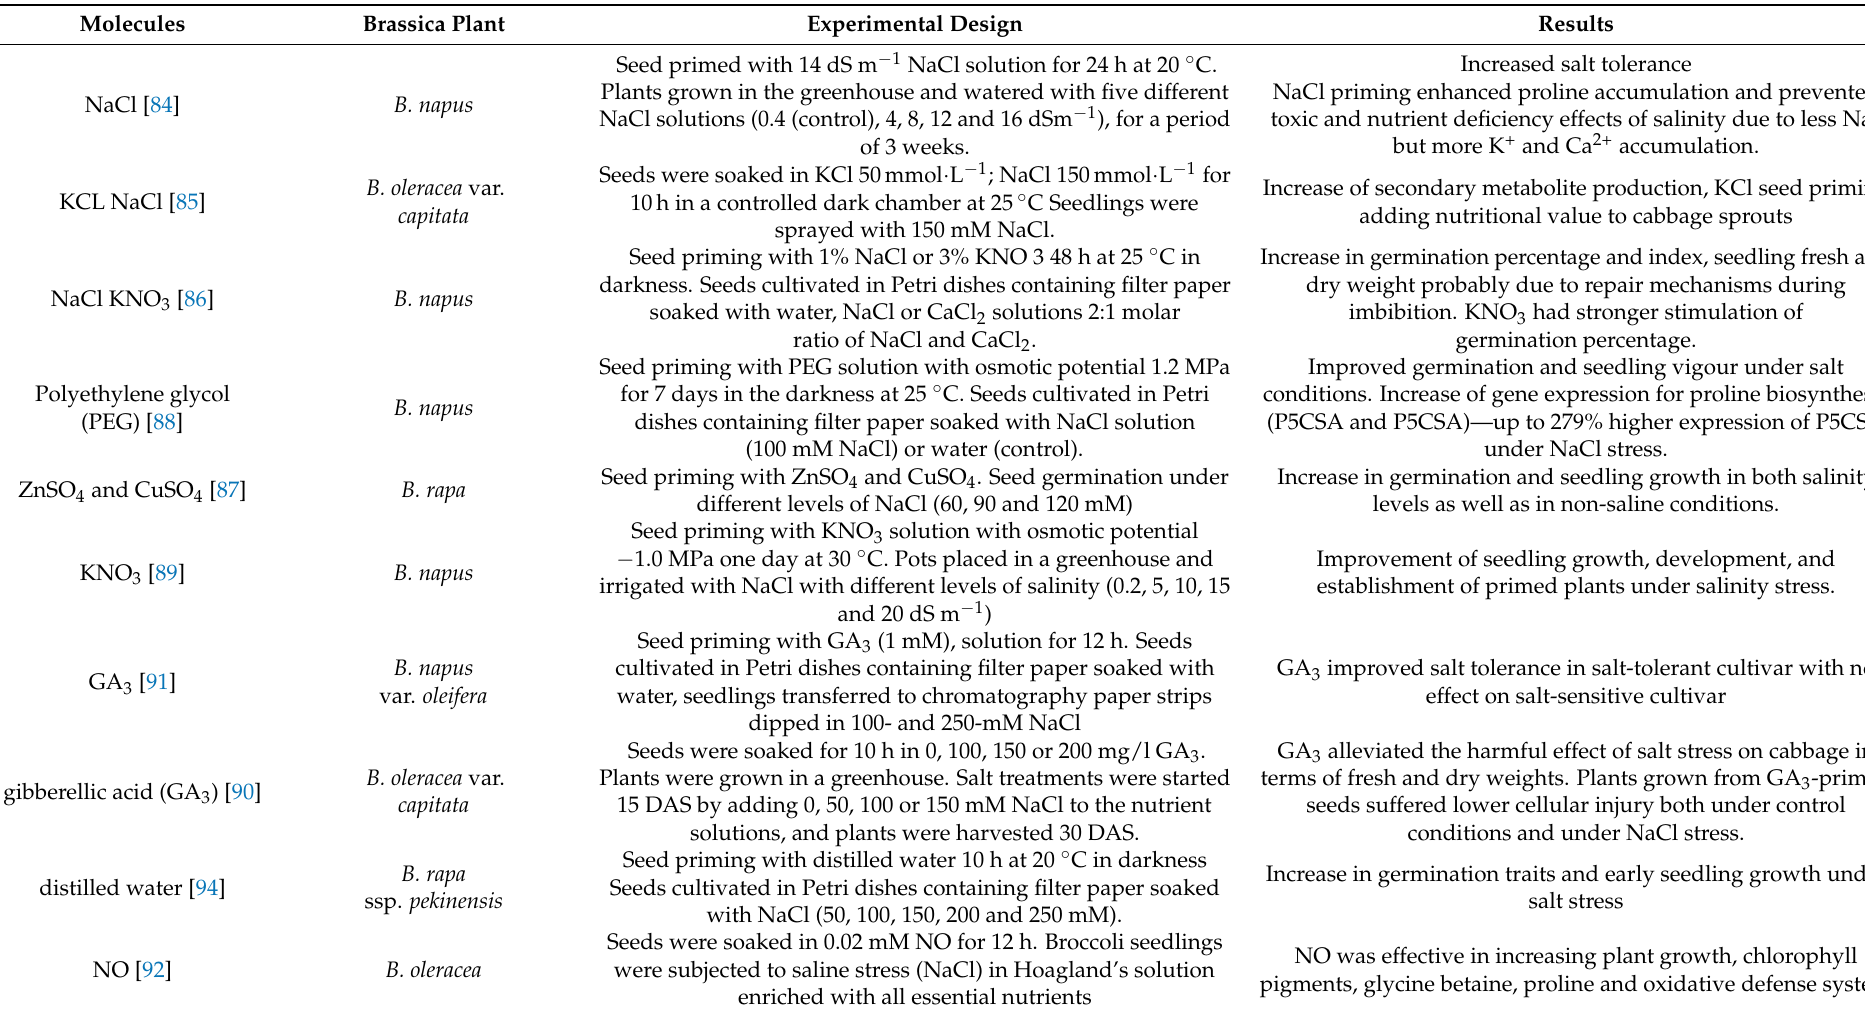
Table 2. List of molecules, experimental design and results of a study on use of seed priming for salt stress tolerance improvement on Brassica